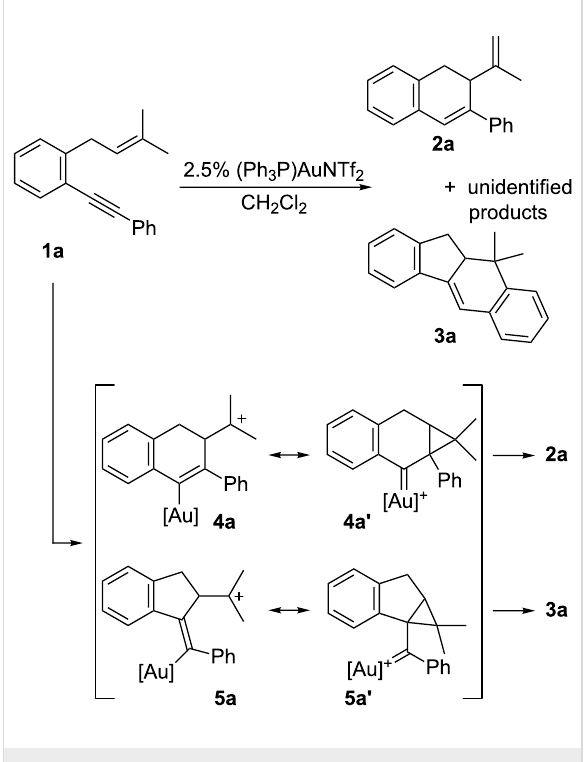
Scheme 4: Gold(I)-catalyzed cycloisomerization of 1a